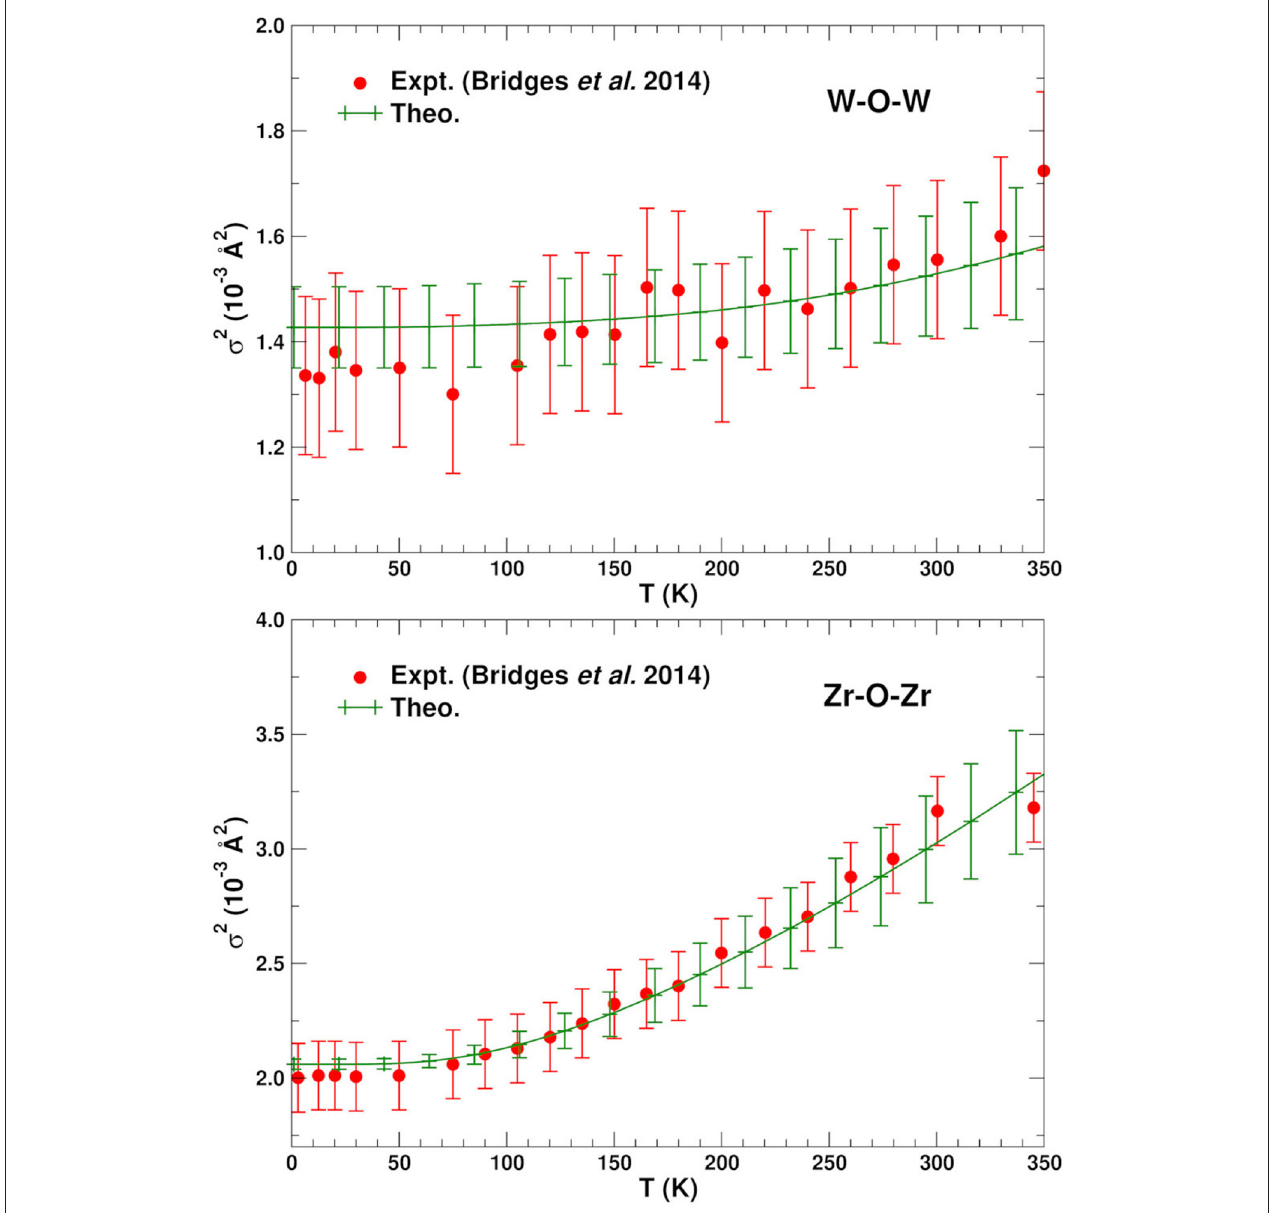
FIGURE 2 | Comparison of the experimental (Bridges et al., 2014) and average theoretical single scattering MSRD σ 2 p for the W–O–W and Zr–O–Zr in ZrW 2 O 8 . The theoretical values have been shifted vertically to account for experimental static disorder.